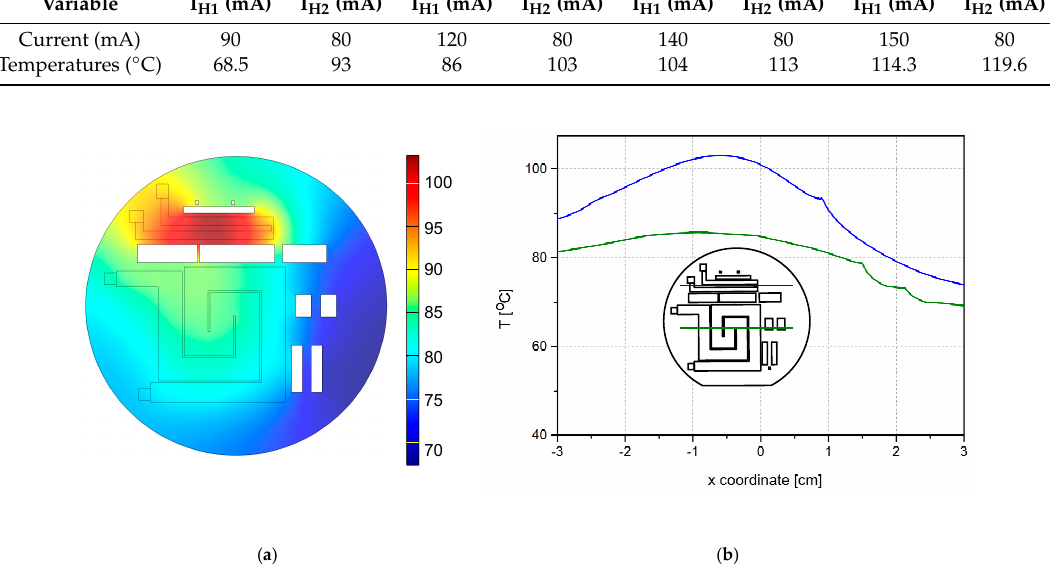
Figure 3. Simulation of temperature distribution on and around the monolithically integrated p-type heaters with the apertures for thermal isolation between the heaters for the current values I H2 = 80 mA and I H1 = 120 mA after 20 min; ( a ) spatial distribution of temperature; ( b ) temperature gradient across the centers of the both heaters. The inset shows both heaters on the wafer, as well as the thermal isolation apertures (centers are marked by horizontal lines). Green lines denote the larger heater H1, while blue lines correspond to the smaller heater H2.